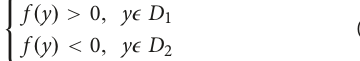
on the training data. The classification process is based on